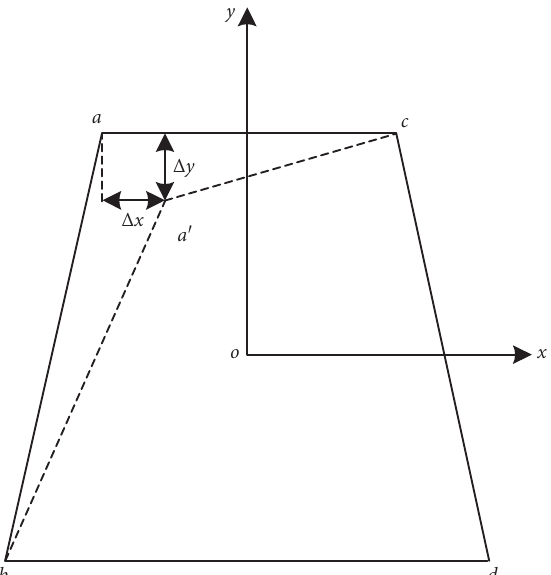
Figure 5: Calibration pattern in image coordinates and the actual localization result of one endpoint: case of point a